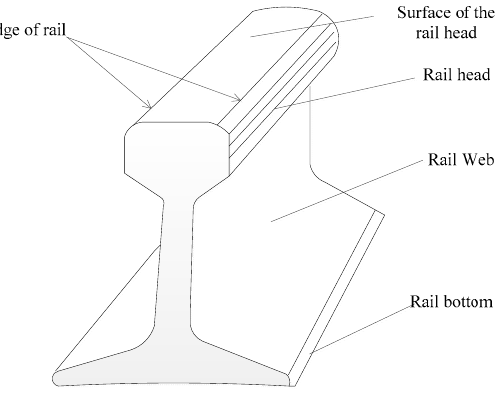
Figure 5. Rail section.